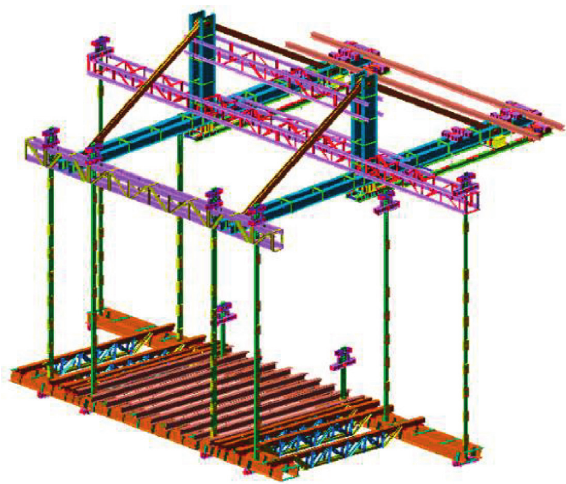
Figure 3: Result-weighing frame diagram of continuous beam.